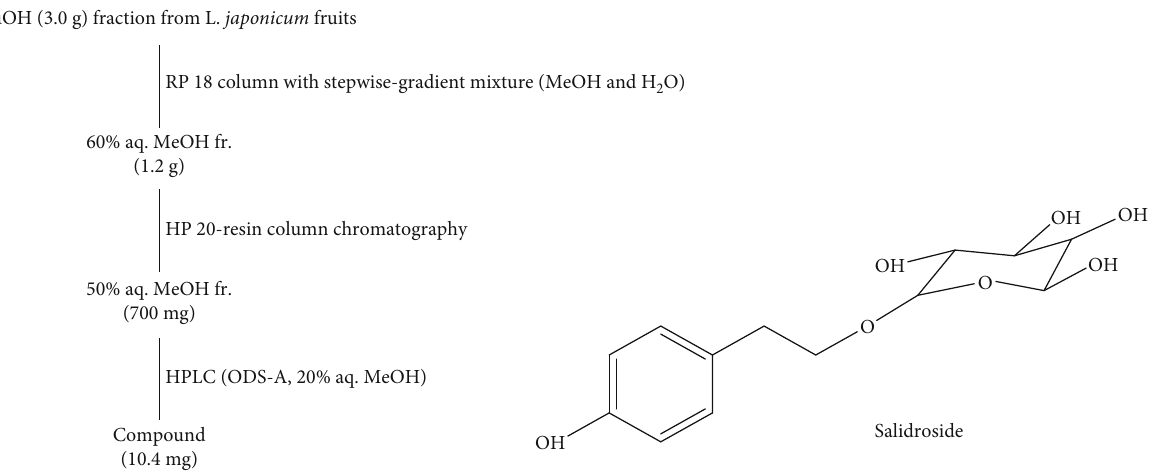
Figure 5: Isolation scheme and chemical structure of